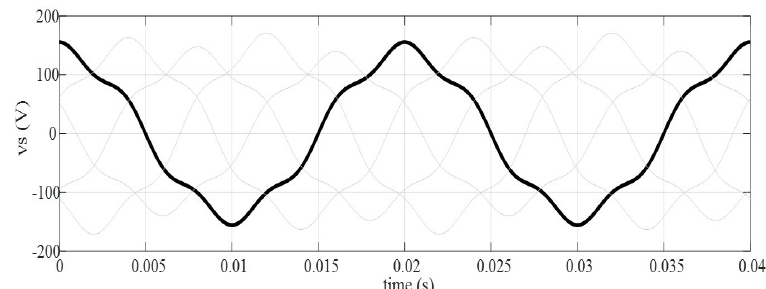
Figure 4. Voltages of a distorted and unbalanced five-phase system; phase 1 is highlighted.